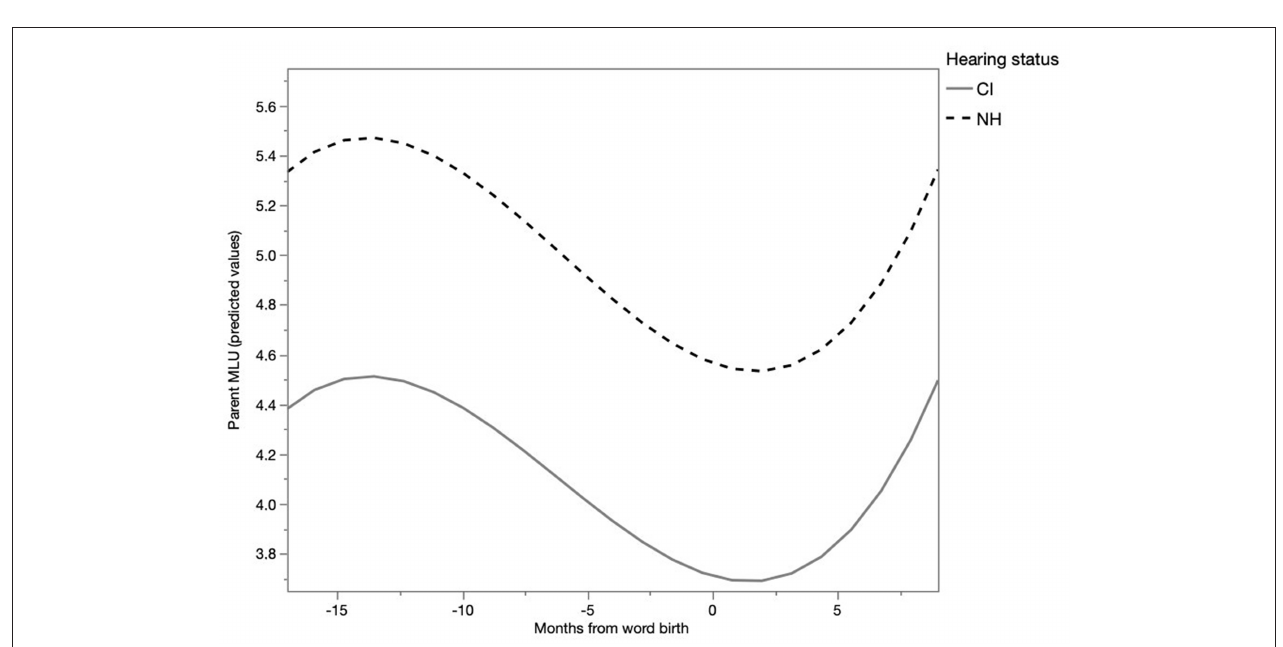
FIGURE 3 | Development of parent MLU according to word birth (predicted